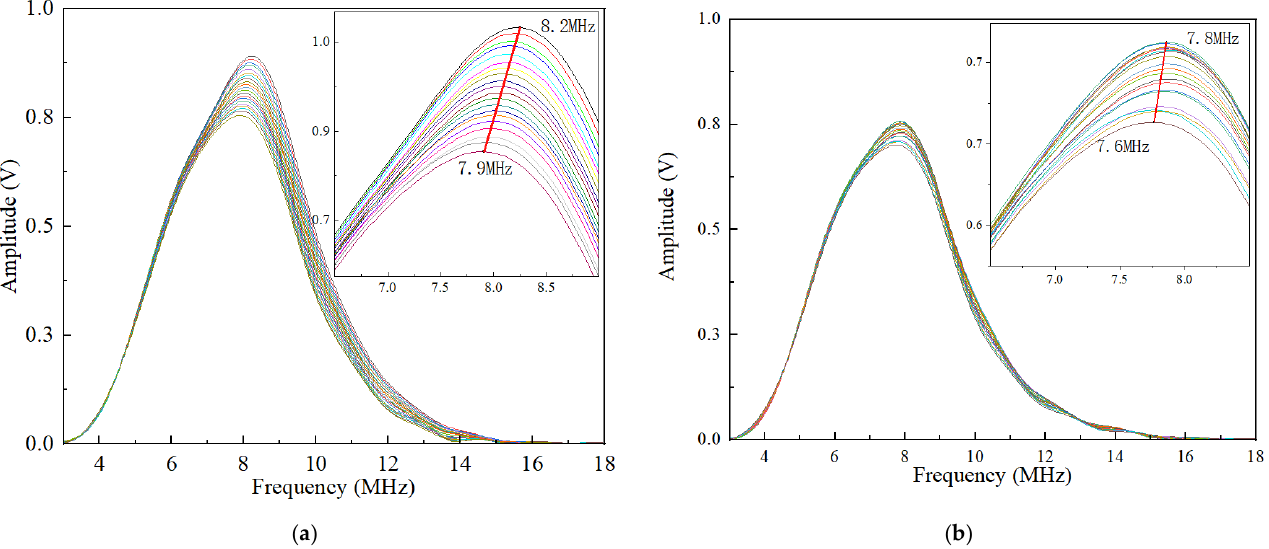
Figure 8. The frequency spectrum of the echo signals under 20 steps axial preload for clamping length of 35.70 mm: ( a ) frequency spectrum of the first round-trip echoes; ( b ) frequency spectrum of the second round-trip echoes.